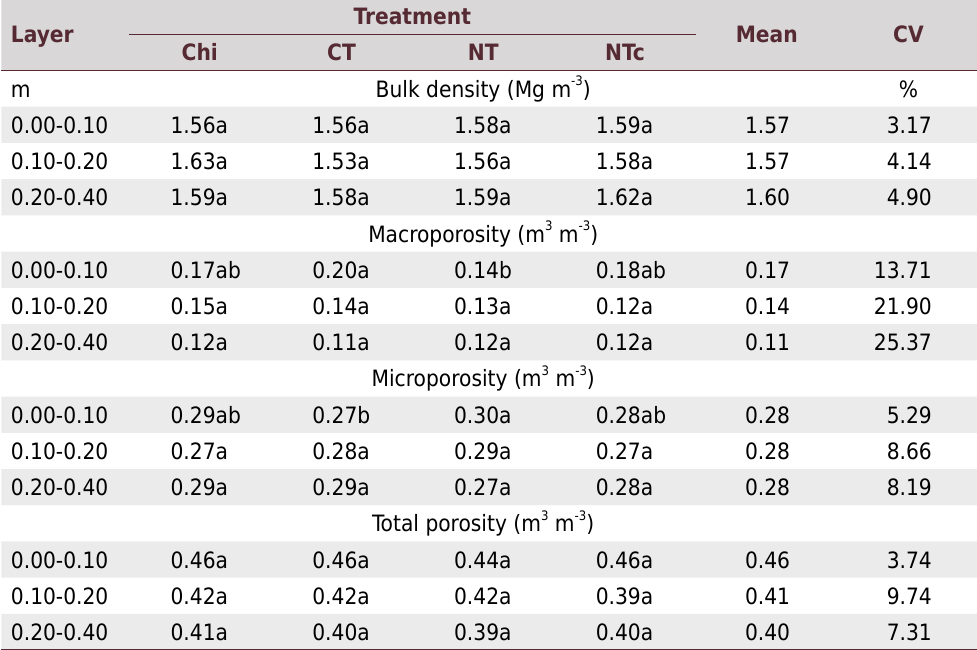
Table 5. Soil bulk density, macro and microporosity, and total porosity in three soil layers and four tillage methods at physiological maturity of the cassava crop